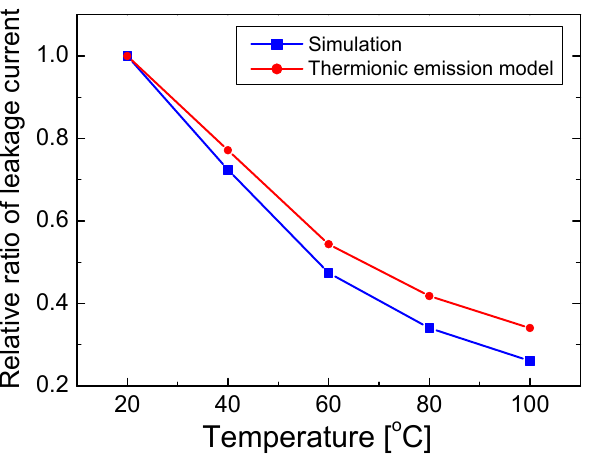
Figure 8. Relative ratios of leakage current ( R leak ) obtained through simulation results in Figure 5, and R leak values obtained using the thermionic emission model in Equation (6) are plotted as a function of temperature.